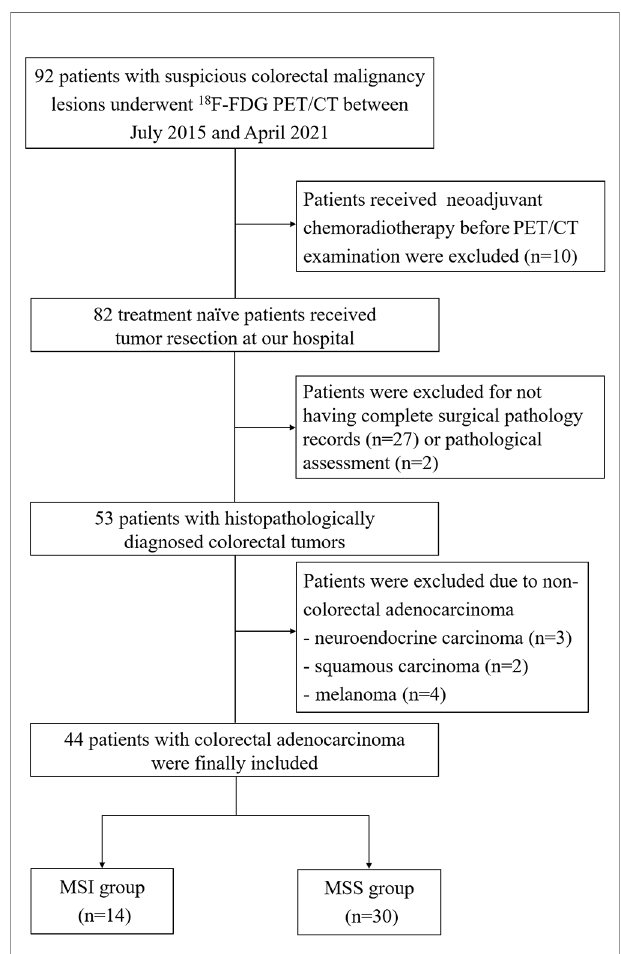
FIGURE 1 | The fl owchart of patient inclusion and